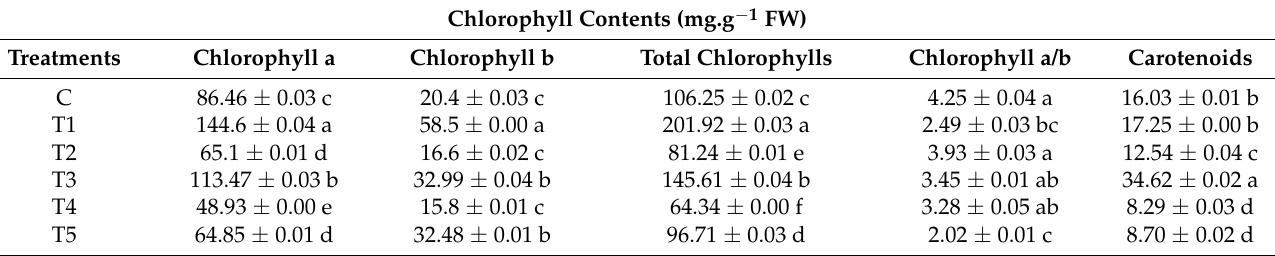
Table 3. Chlorophyll contents in A. rosea plants under different Cd treatments. Values indicate mean values ± standard error. Where T1 = 5mM.kg -1 CA, T2 = 100 mg.kg -1 Cd, T3 = 100 mg.kg -1 + 5 mM.kg -1 , T4 = 200 mg.kg -1 Cd, and T5 = 200 mg.kg -1 + 5 mM.kg -1 . The different lowercase letters on the vertical bars represent significant differences among the treatments at p < 0.05.